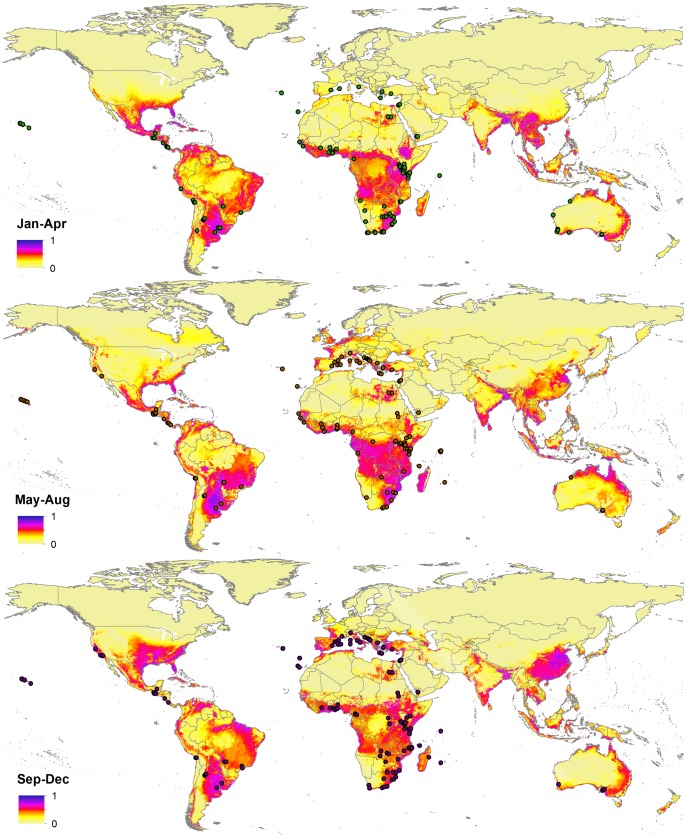
3-panel seasonal maps showing the environmental suitability for C. capitata occurrence annually according to the MaxEnt model.Dots represent the seasonal presence points used in the seasonal potential niche modelling. Blue, purple and red colors show high confidence in predicted suitability, while yellow represents low confidence and predicted absence.